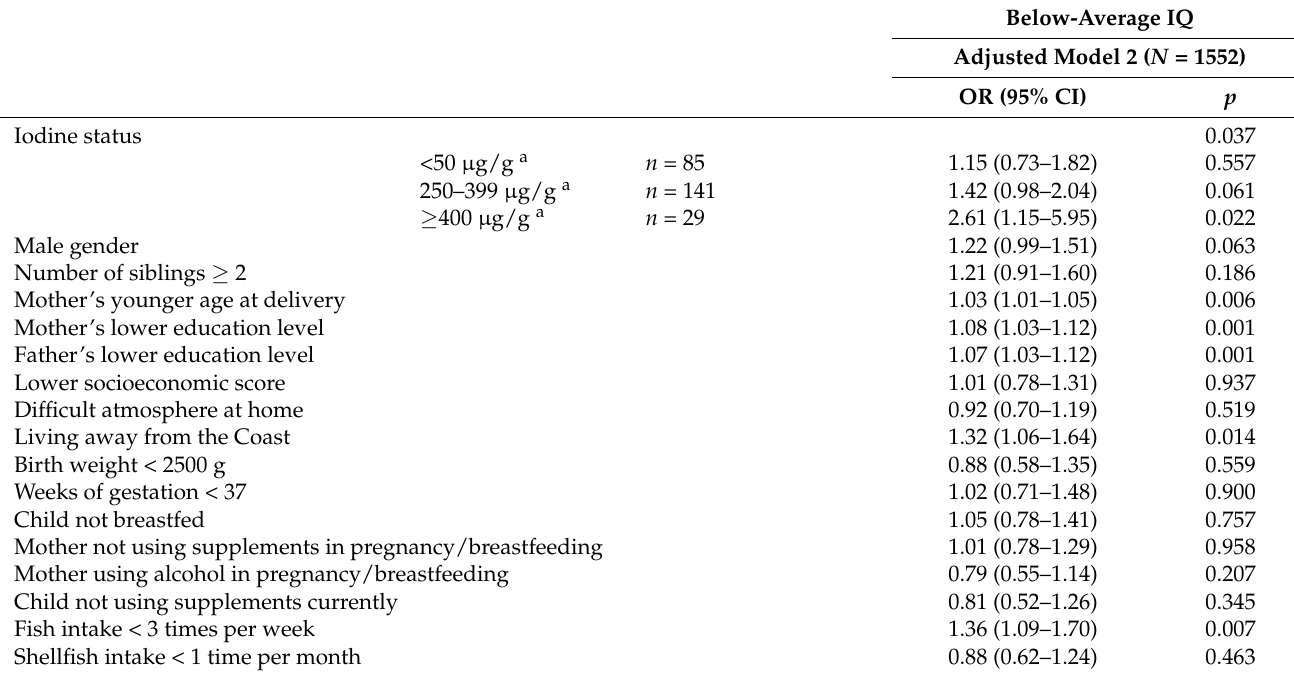
Table 3. Odds of lower IQ for subdivided elevated urinary iodine concentrations (also considering values below 50 µ g/g), adjusted for possible